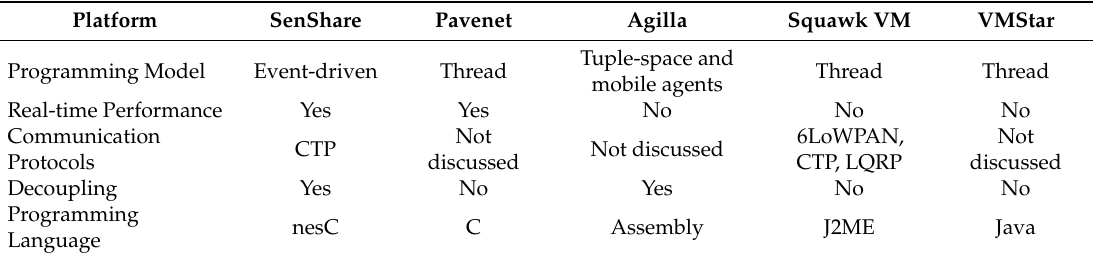
Table 2. Comparison table for wireless sensor middleware and VM-based